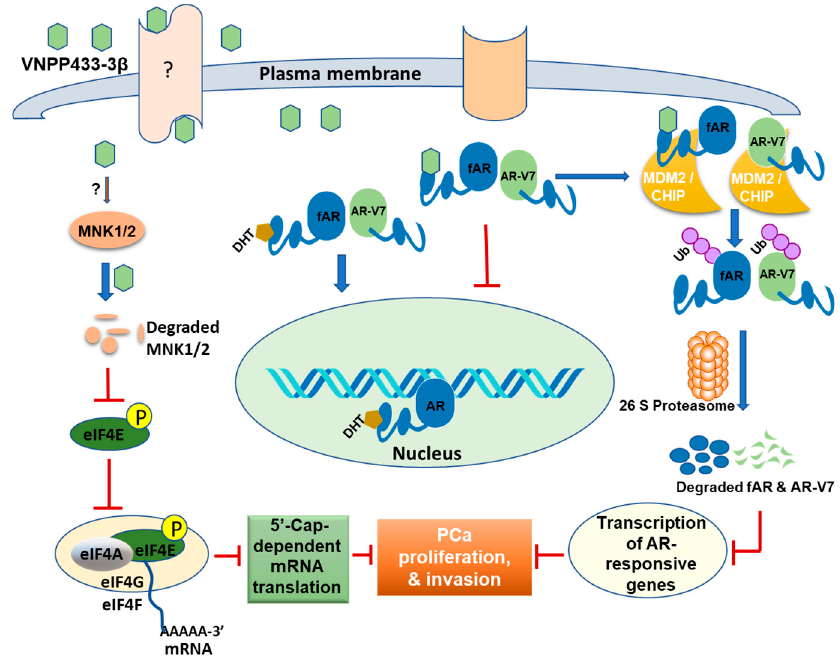
Figure 7. Graphical representation of the mechanism of action of VNPP433-3 β in PCa inhibition. VNPP433-3 β binds the AR, prevents its translocation into the nucleus, and redirects it to ubiquitination by MDM2/CHIP and subsequent degradation by 26 S proteasome thereby affecting transcription of AR-responsive tumor genes and affecting PCa inhibition. Additionally, VNPP433-3 β impedes phosphorylation of eIF4E by depleting MNK1/2 that in turn limits 5 ′ -cap-dependent translation and blocks PCa progression.